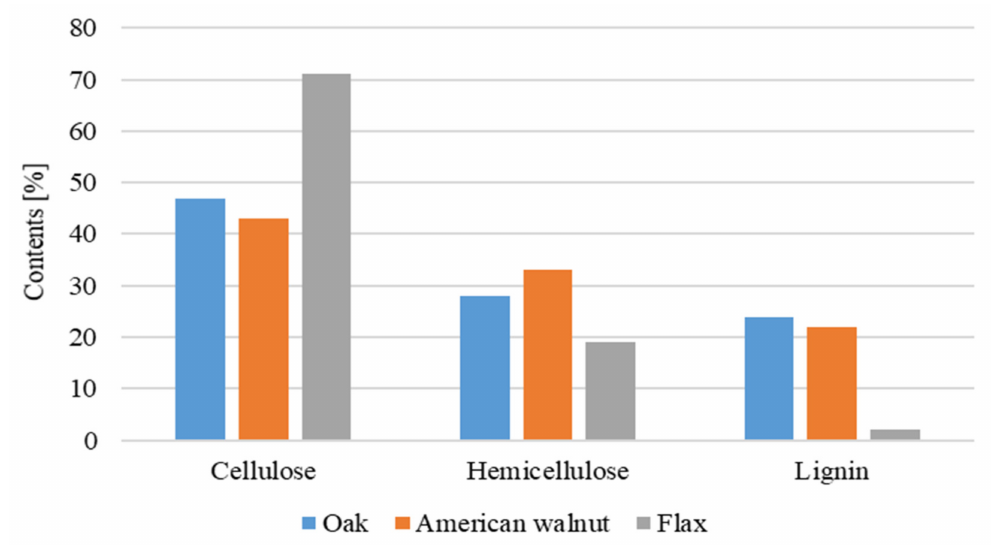
Figure 1. The content of cellulose, hemicellulose and lignin in oak, American walnut and flax